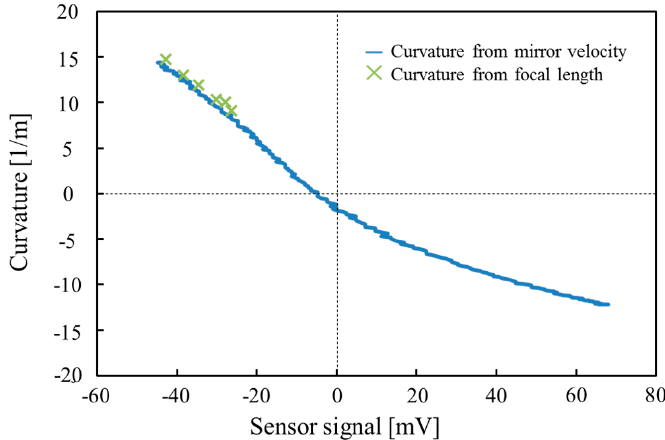
Figure 12. Curvature as a function of the piezoresistor signal.